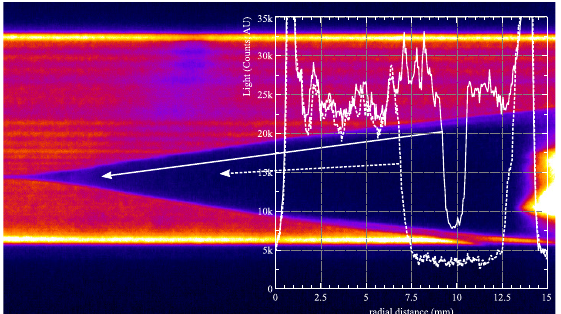
Figure 7. (Color online) streak image from an iron experiment with 15 kV in the capacitors bank. Superimposed graph shows the intensity traces at the approximate positions marked by the arrows. There are differences not only in width, but also in attenuation, with the latter getting larger as the metal gas expands and absorb more electrical energy from the